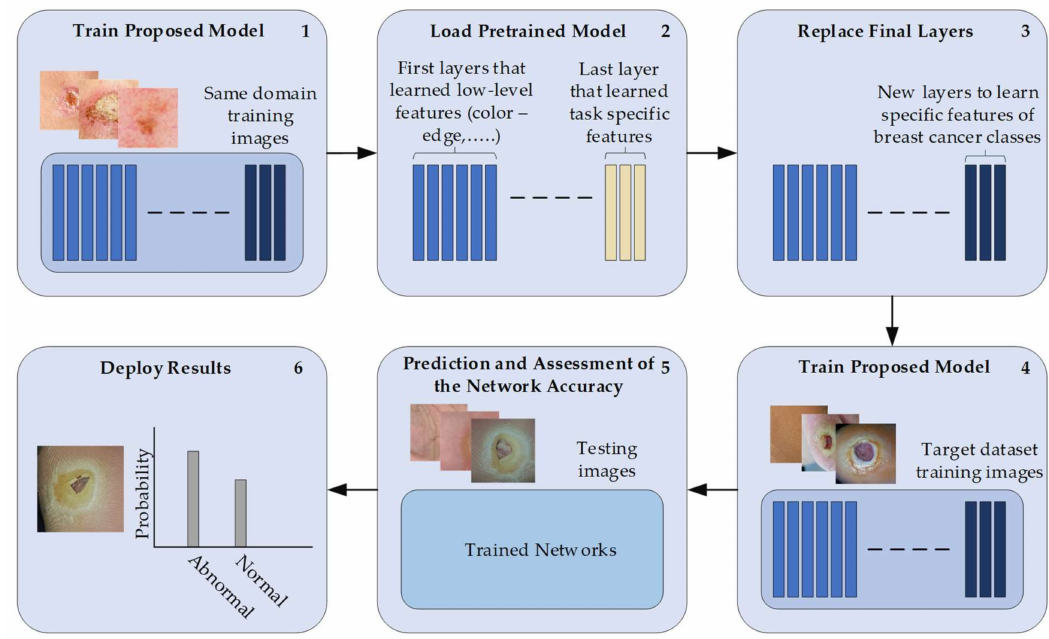
Figure 7. Transfer leaning